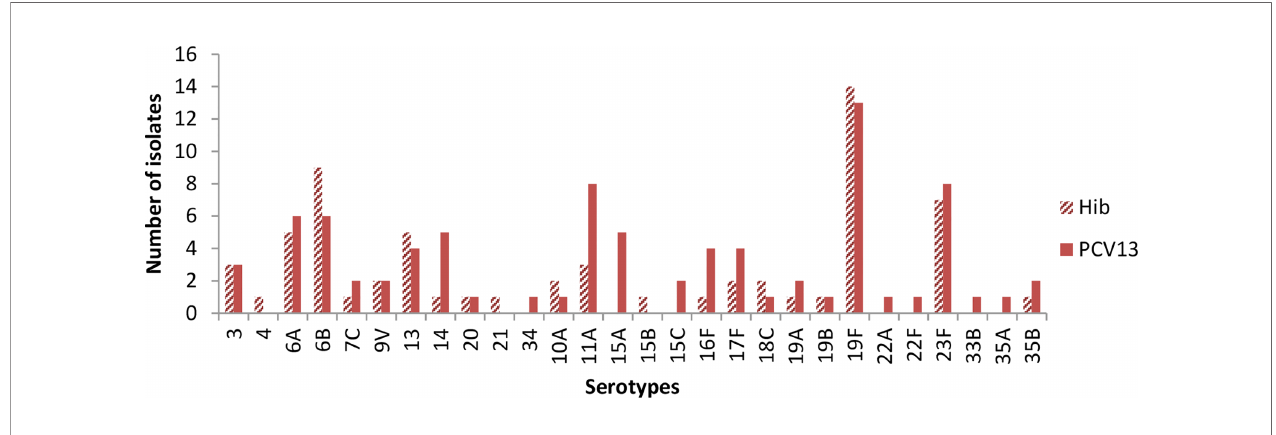
FIGURE 2 | Pneumococcal serotypes isolated at baseline.